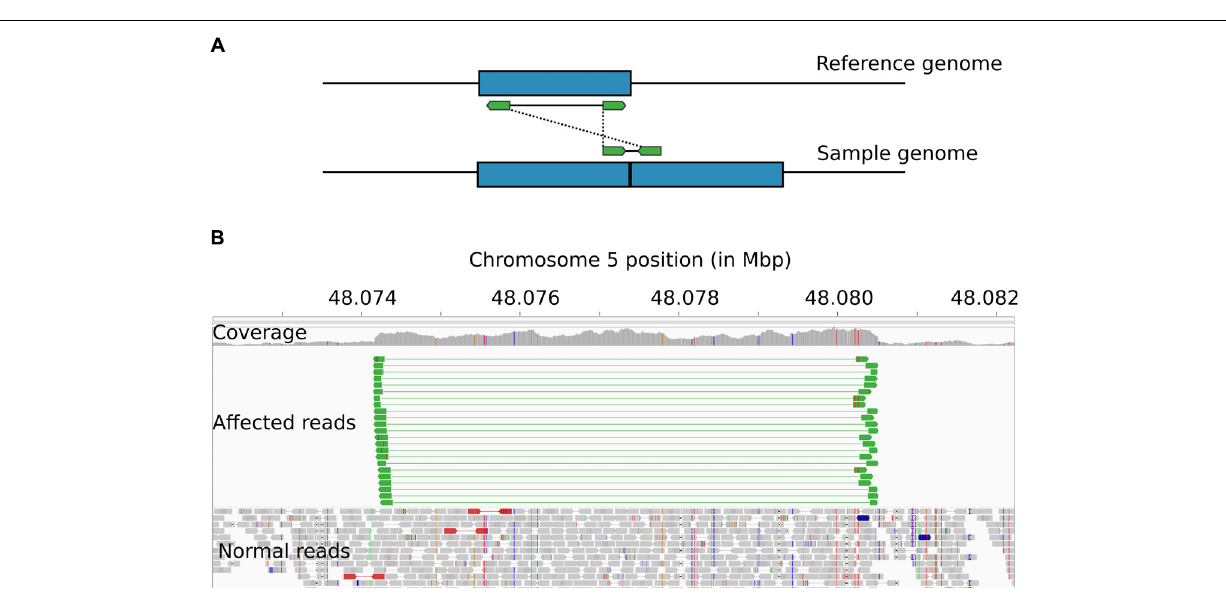
FIGURE 3 | Structural arrangement of the HMGA2 -CNVR. (A) Schematic of the alignment of paired-end reads (in green) derived from an insert encompassing the boundaries of two repeats of a duplicated genomic segment (in blue). When the reads are aligned against the reference genome, the insert appears to be much larger than expected, usually spanning the entire length of the duplicated segment. Additionally, the tandem arrangement causes read pairs to be oriented toward the outer sides of the predicted insert. (B) IGV visualization of the HMGA2 -CNVR in a whole-genome sequenced B. indicus animal showing several paired-end reads (in green) satisfying the pattern described